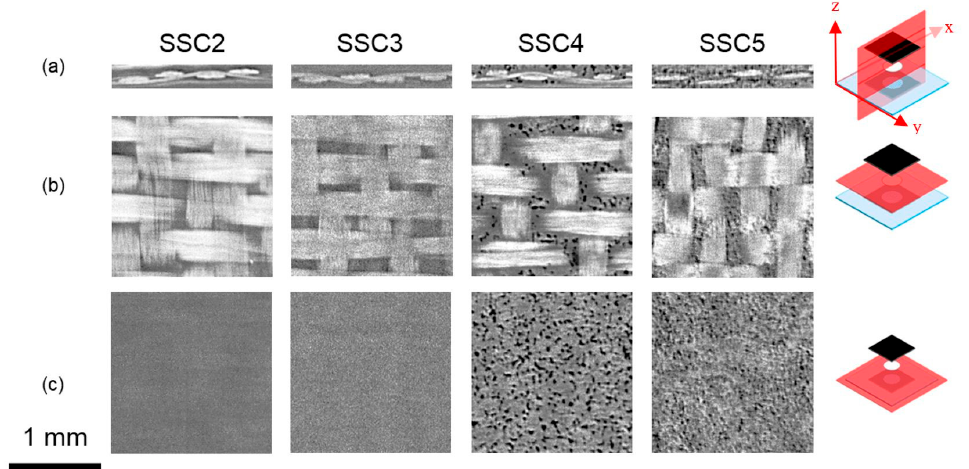
Figure 4. XµCT cross-sections of SSC2 to SSC5. ( a ) Cross-section taken through the x-z plane, while ( b , c ) show cross-sections taken through the x-y planes at the centre of the glass layer and at the electrolyte/CNT electrode interface, respectively. The x-y-z orientation and section location are indicated at the right-hand side.